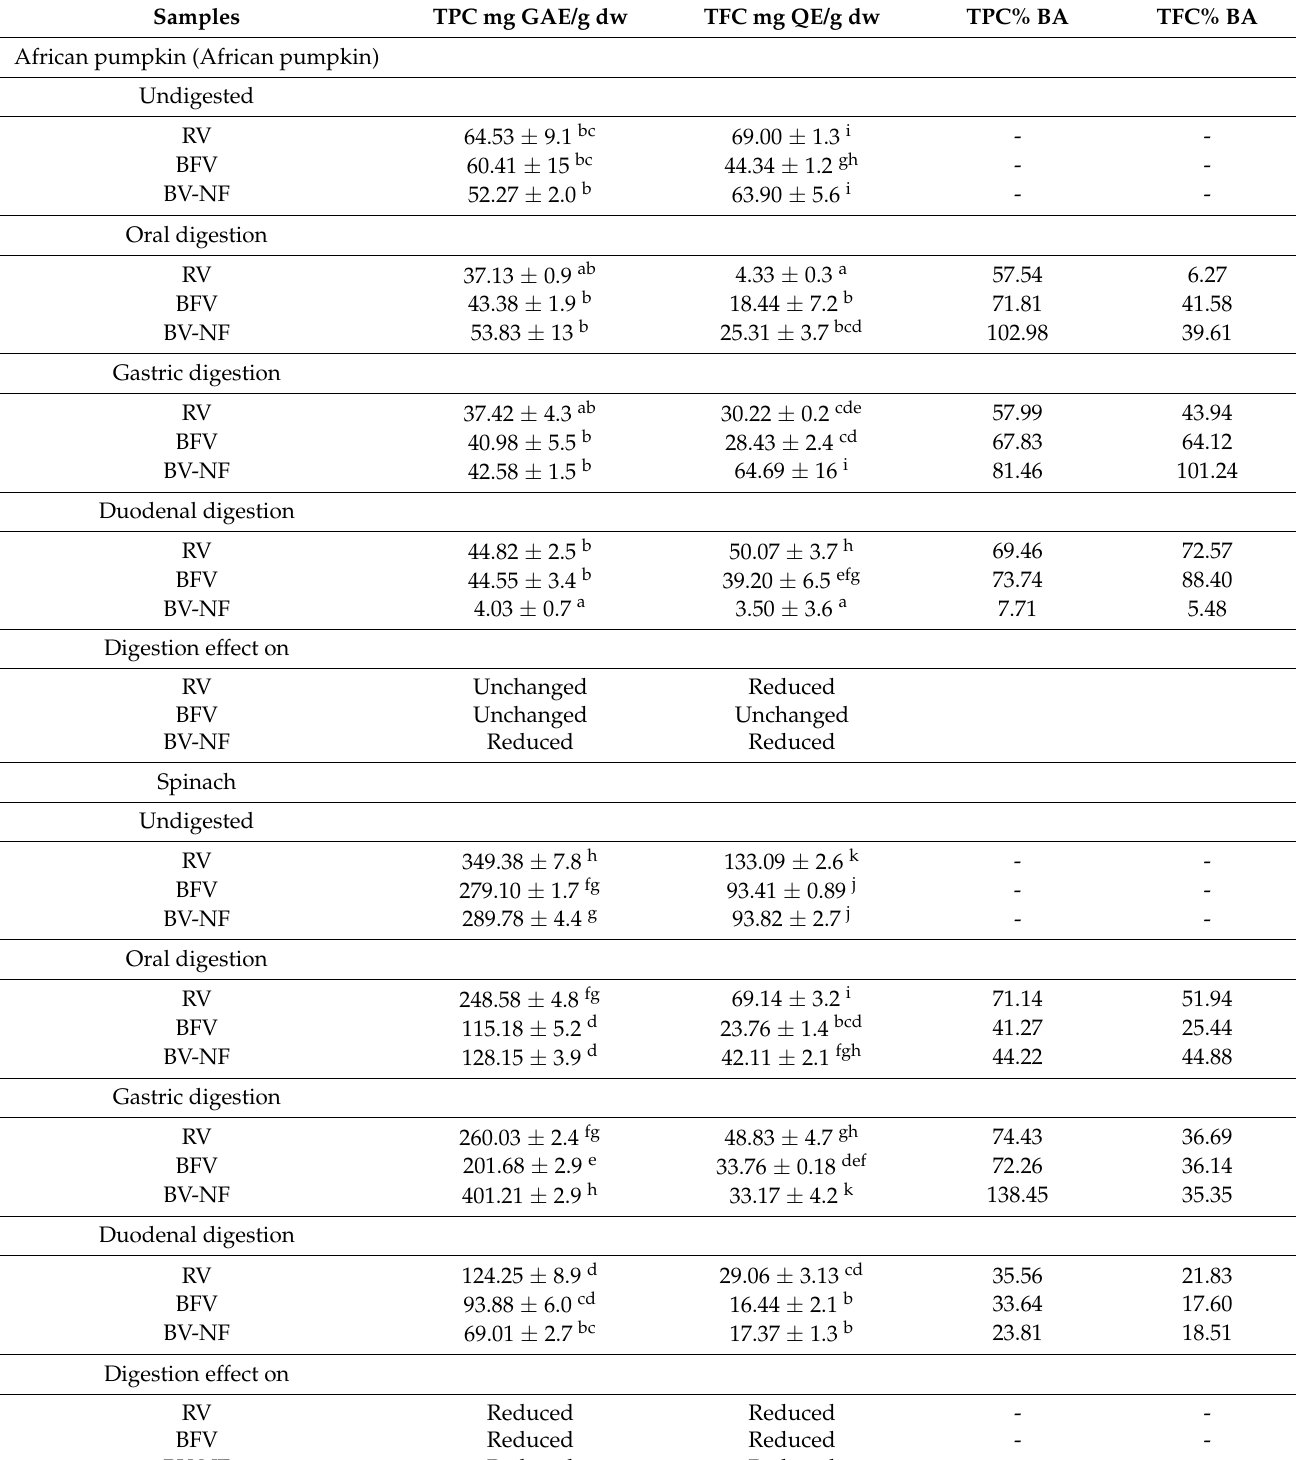
Table 2. Total phenolic contents (TPC), total flavonoid content (TFC), and % bioaccessibility (% BA) of African pumpkin and